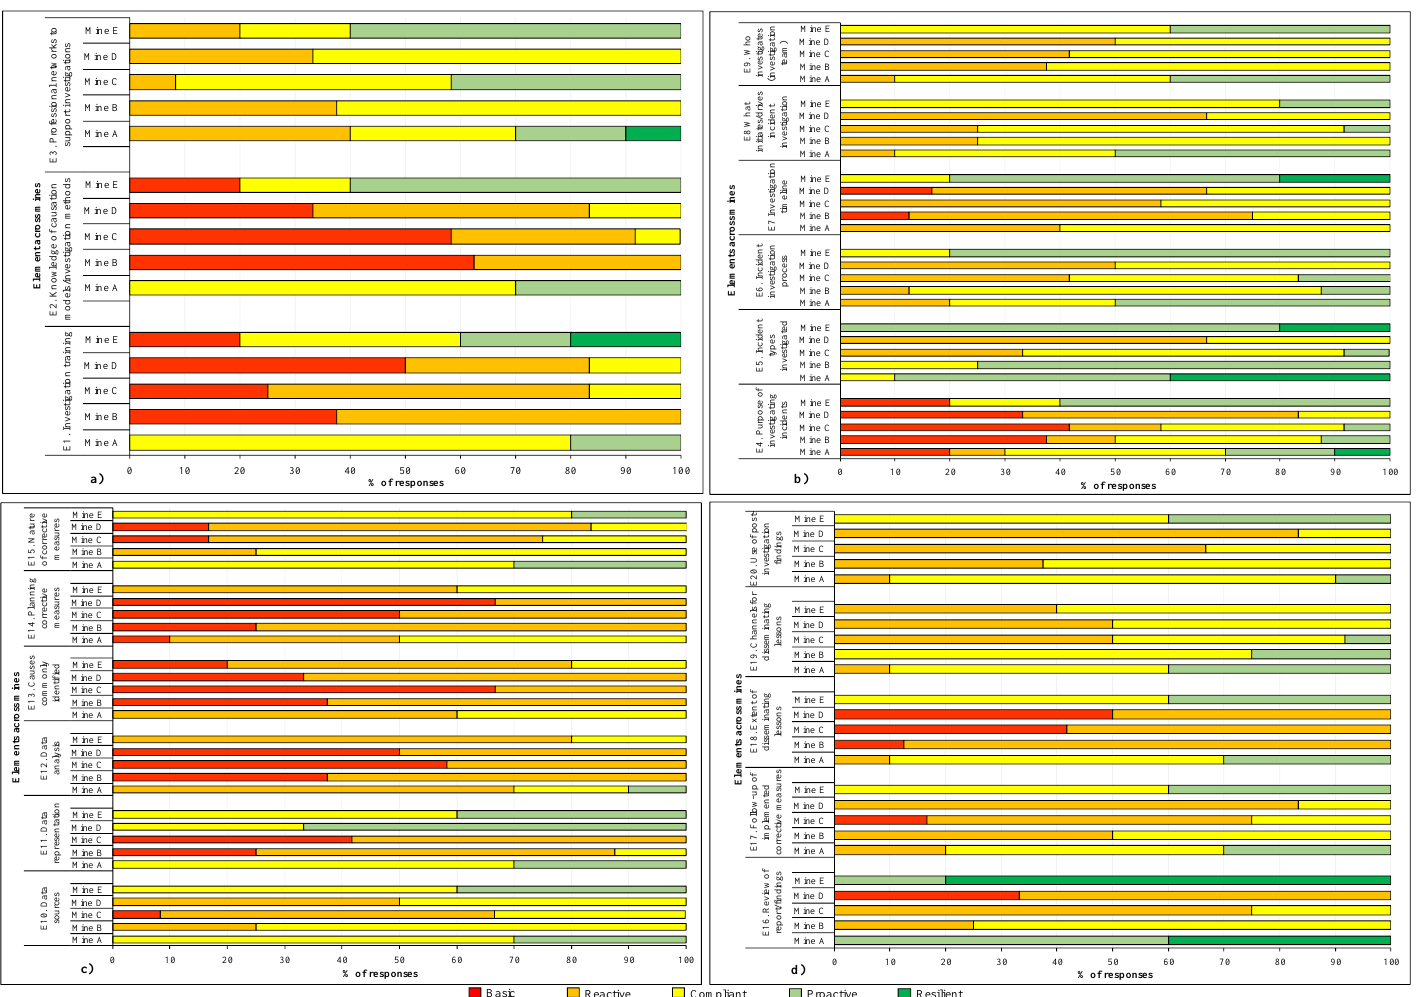
Figure 2. Incident investigations maturity levels across the five mines: ( a ) investigator competencies dimension, ( b ) system of investigation dimension, ( c ) stages of investigation dimension, ( d ) post-investigation findings.